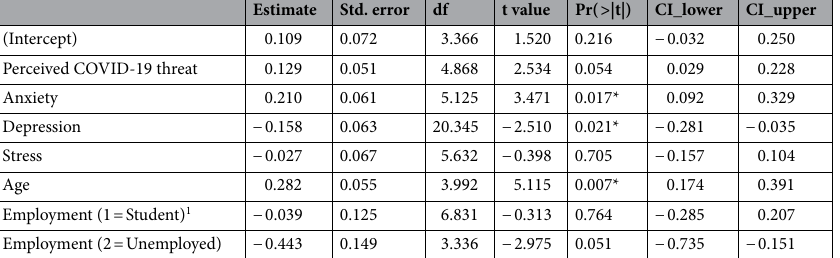
Table 4. Model 4 estimates (DV: Donations). 1 Reference class = Employed.